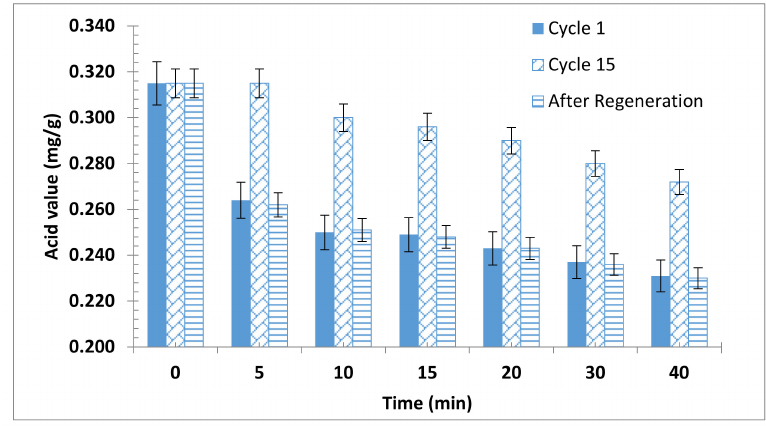
Figure 4. Bioadsorbent